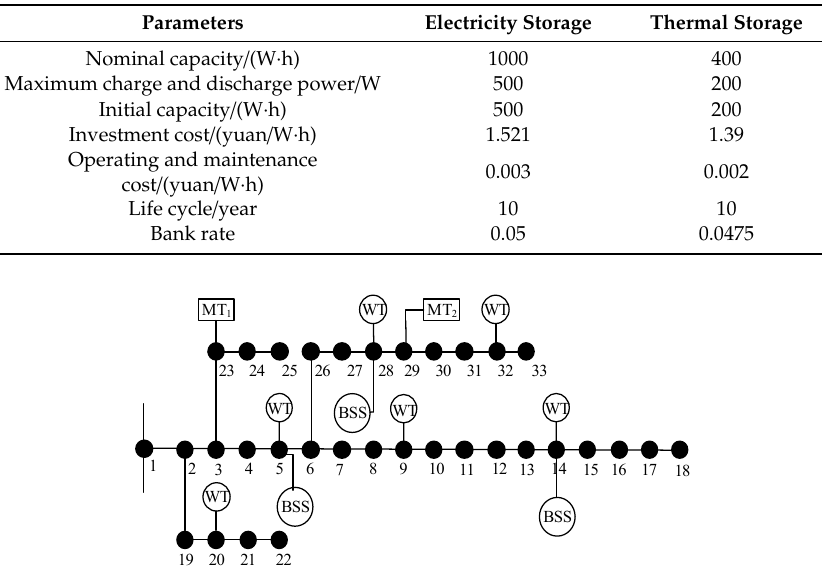
Figure 4. Structure diagram of IEEE 33-bus distribution network.